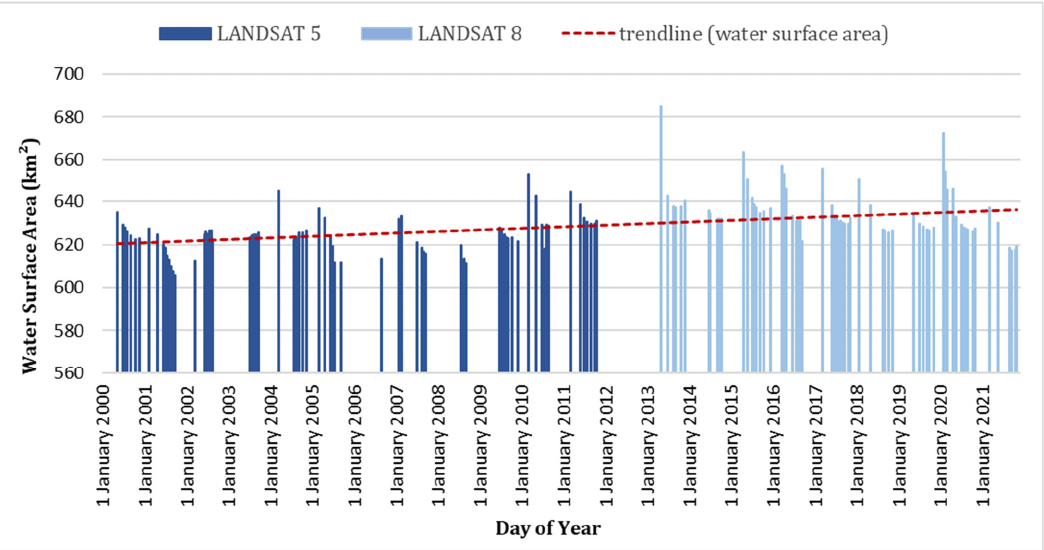
Figure 9. Water surface area temporal changes and trendline for Lake Beysehir between 2000 and 2021.